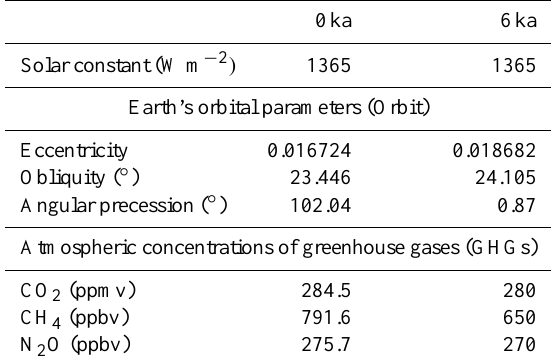
Table 1. Boundary conditions used for 0ka and 6ka